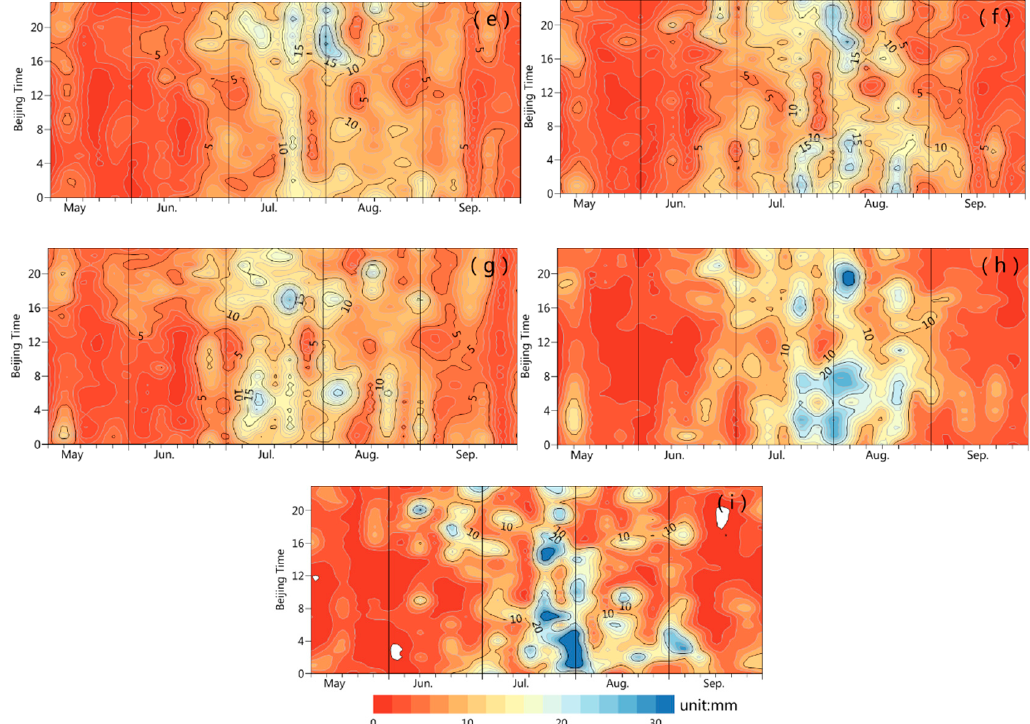
Figure 7. The pentad variations of the hourly mean precipitation for tributaries in the Haihe River basin, 2007–2017. (( a ), Luanhe River; ( b ), Beisan River; ( c ), Yongding River; ( d ), Daqing River; ( e ), Ziya River; ( f ), Nanyun River; ( g ), Zhangwei River; ( h ), Tuma River; ( i ), low reach of Haihe River).